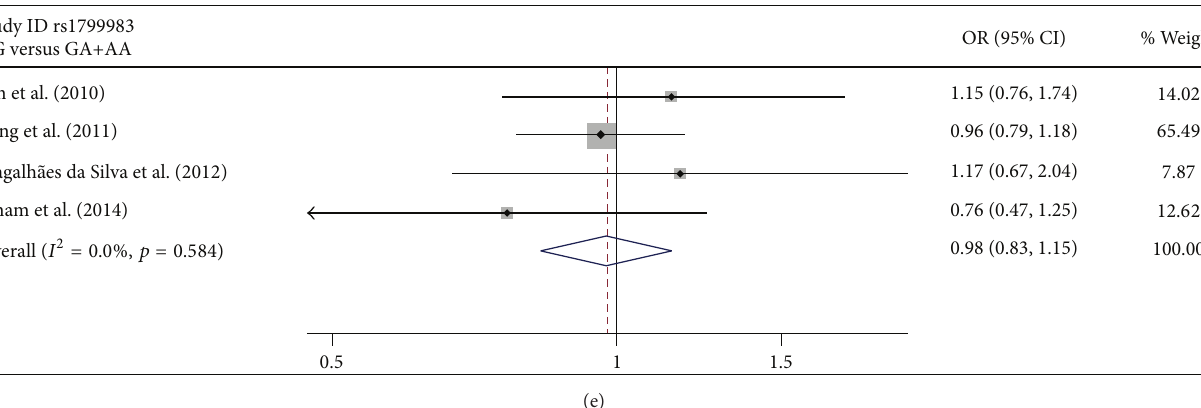
Figure 3: Forest plots of the association of rs1799983 with POAG. Every study was represented by a square whose size was proportional to the weight of the study. Diamond indicated summary odds ratios (ORs) with its corresponding 95% confidence interval (95% CI). (a) Forest plot for rs1799983 and POAG risk in the genetic model of G-allele versus A allele. (b) Forest plot for rs1799983 and POAG risk in the genetic model of GG versus AA. (c) Forest plot for rs1799983 and POAG risk in the genetic model of GA versus AA. (d) Forest plot for rs1799983 and POAG risk in the genetic model of GG + GA versus AA. (e) Forest plot for rs1799983 and POAG risk in the genetic model of GG versus GA +